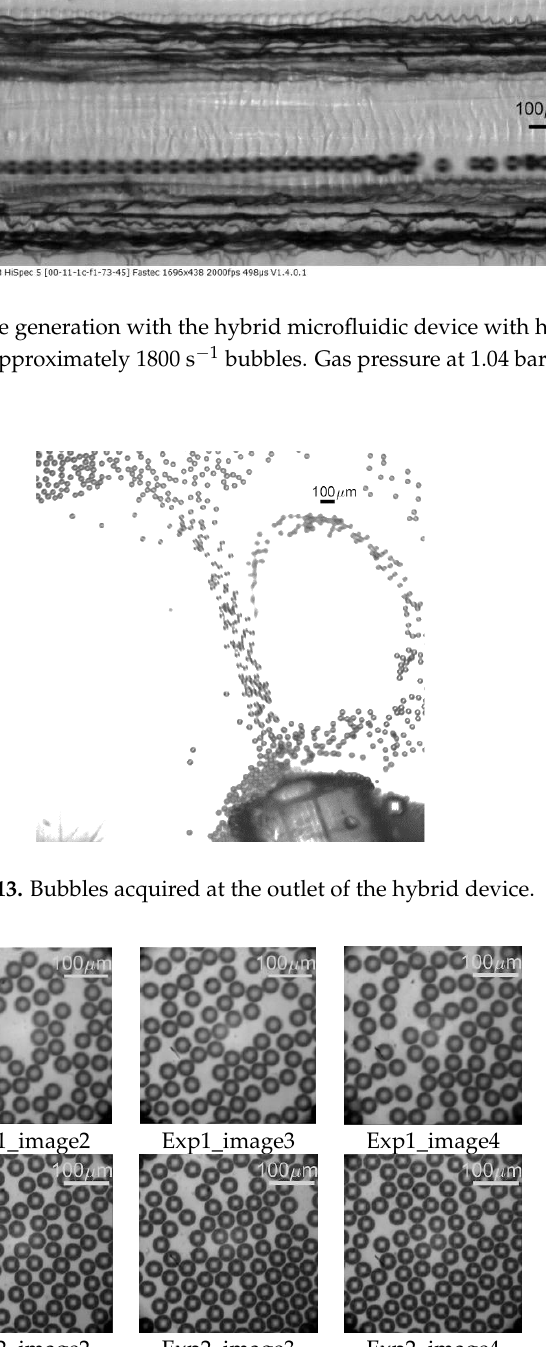
Figure 14. Images of microbubbles from each experiment performed.